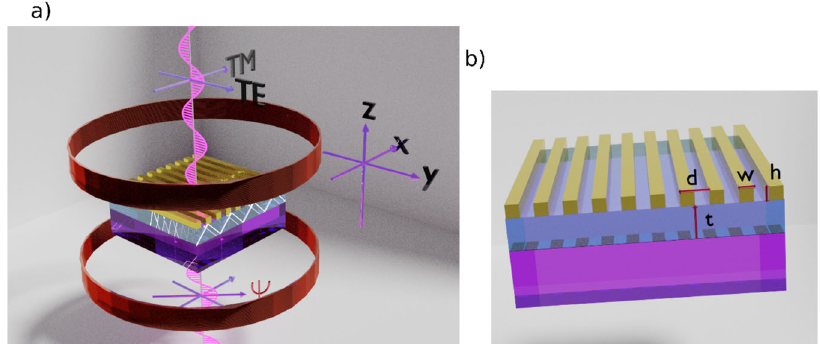
Fig. 1 The waveguide magneto-plasmonic crystal (WMPC). a A schematic illustration of the fi nite element method (FEM) simulation of Faraday rotation ψ in the transmission spectra of the WMPC system. The direction of the transverse magnetic TM (x) and transverse electric TE ( y ) polarized light electric fi elds are perpendicular and parallel (respectively) to the axis of the Au gratings in the WMPC. b The WMPC system comprises of gold (Au) gratings on top of a thin yttrium-bismuth iron garnet (Y-BIG) fi lm and the substrate is taken to be quartz. The Y-BIG fi lm serves as the waveguiding layer and additionally exhibit Faraday effect in the presence of an external magnetic fi eld. The thickness of the Y-BIG fi lm ( t ) and the periodicity ( d ), width ( w ), and height ( h ) of the Au gratings are